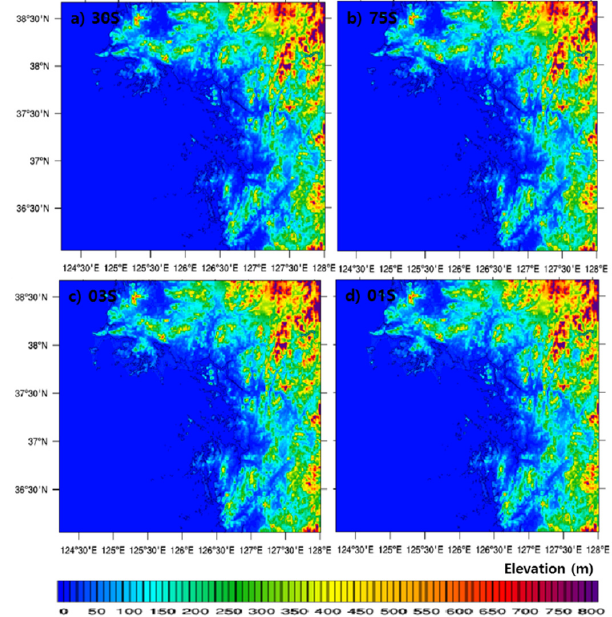
Figure 2. Distribution of surface height in the inner domain for ( a ) Control; ( b ) 75S; ( c ) 03S; and ( d ) 01S. The colorbar represents elevation in meters.